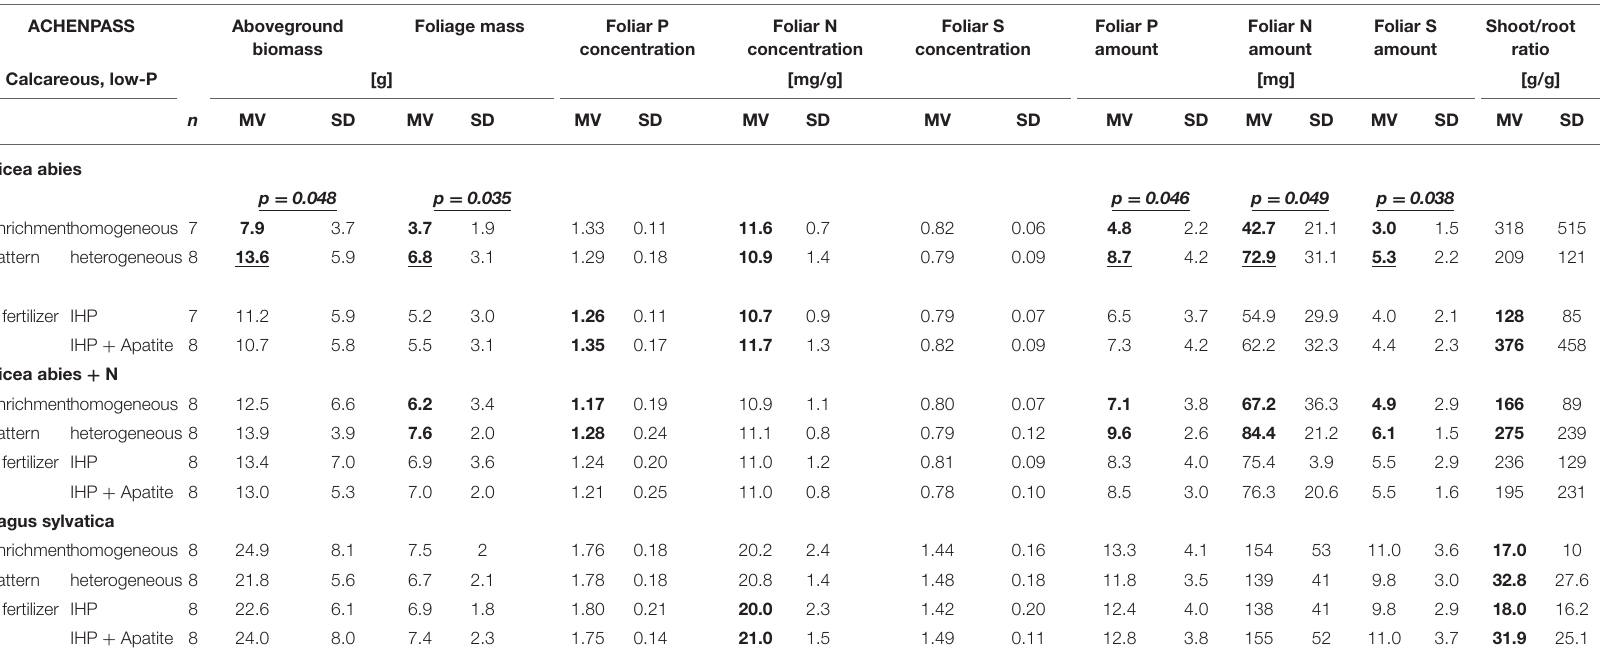
TABLE 2 | Effects of spatial P enrichment pattern and P fertilizer type on growth and nutrition of Picea abies and Fagus sylvatica seedlings in the field experiment at the low-P calcareous site Achenpass (Calcaric Leptosol). ACHENPASS Aboveground